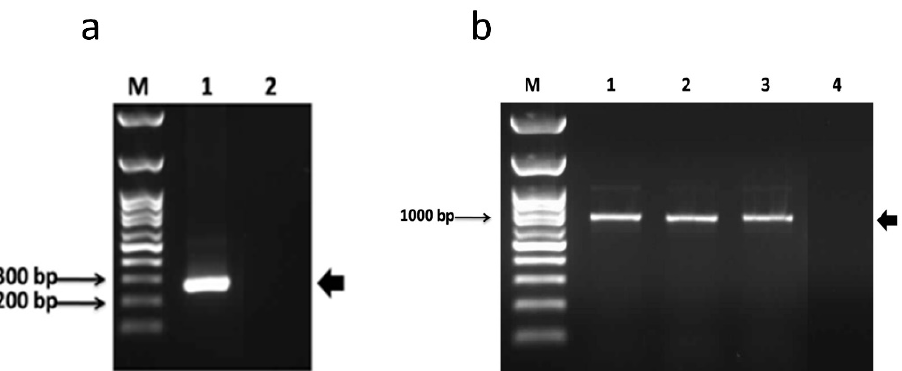
Figure 2. PCR confirmation of the pPICZ α A-ZIKV-EDIII construct and transformation of K. phaffii . ( a ) PCR of pPICZ α A-ZIKV-EDIII confirming the correct cloning of the cassette on the vector. M: molecular weight marker; 1: amplified fragment of pPICZ α A-ZIKV-EDIII; 2: empty pPICZ α A used as the negative control. ( b ) PCR of K. phaffii genomic DNA. M: molecular weight marker; 1–3: transformed K. phaffii clones; 4: untransformed K. phaffii (negative control).